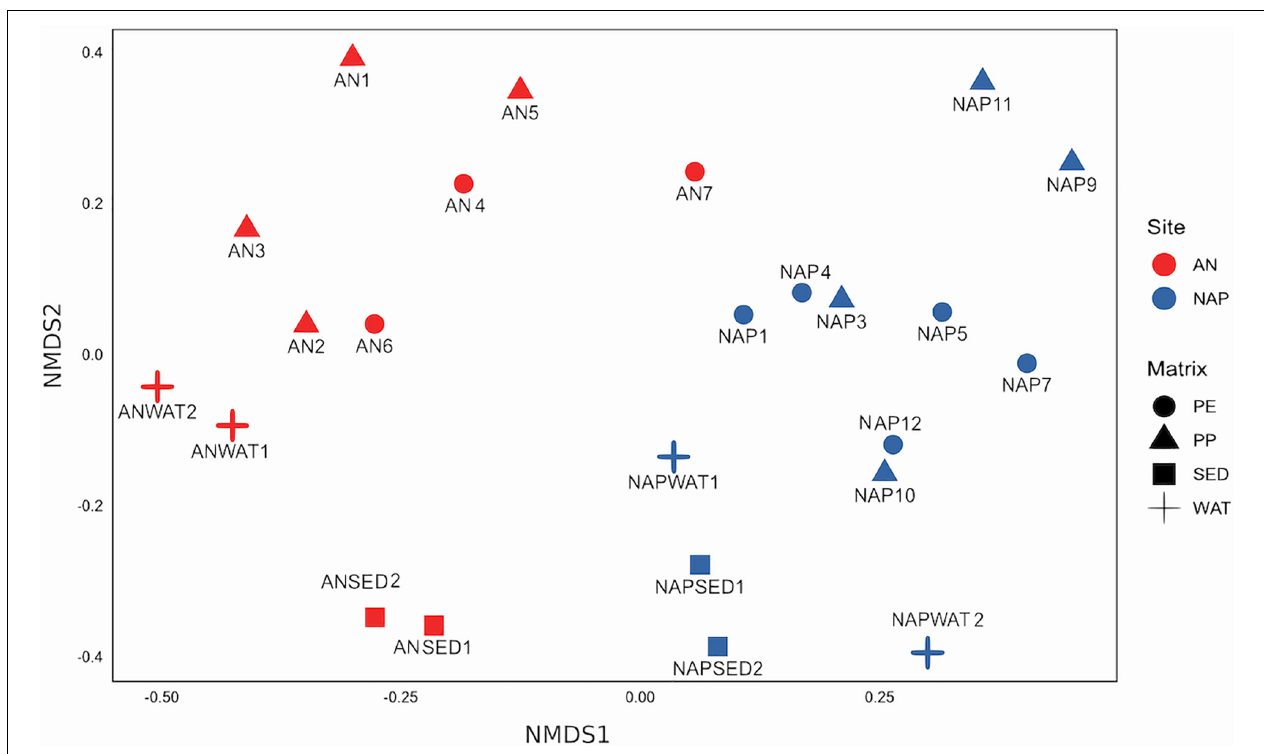
FIGURE 4 | Non-metric MDS (nMDS) ordination of community composition (based on 16S rRNA gene analysis and values of Bray–Curtis dissimilarity) in the different sites and samples investigated. Shape represents different substrate, and color represents the sites. Stress value =